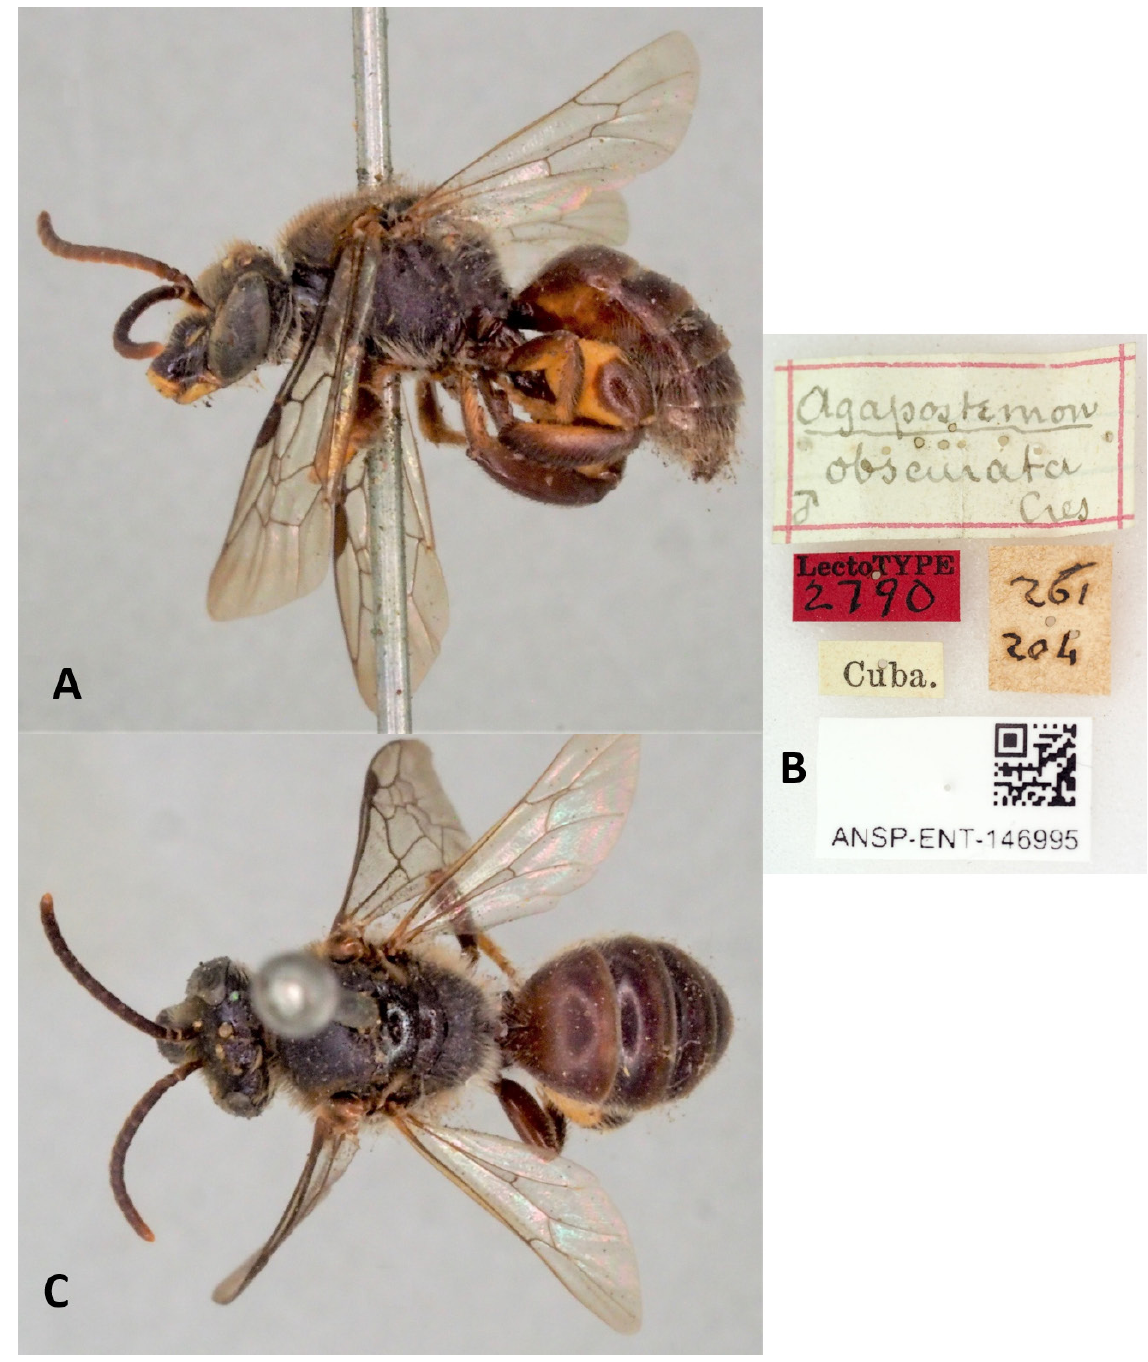
Fig. 5. Agapostemon obscuratus Cresson, 1869. Lectotype, ♂ (ANSP 2790). A . Lateral view. B . Associated labels. C . Dorsal view. Photos by J.D. Weintraub/ANSP